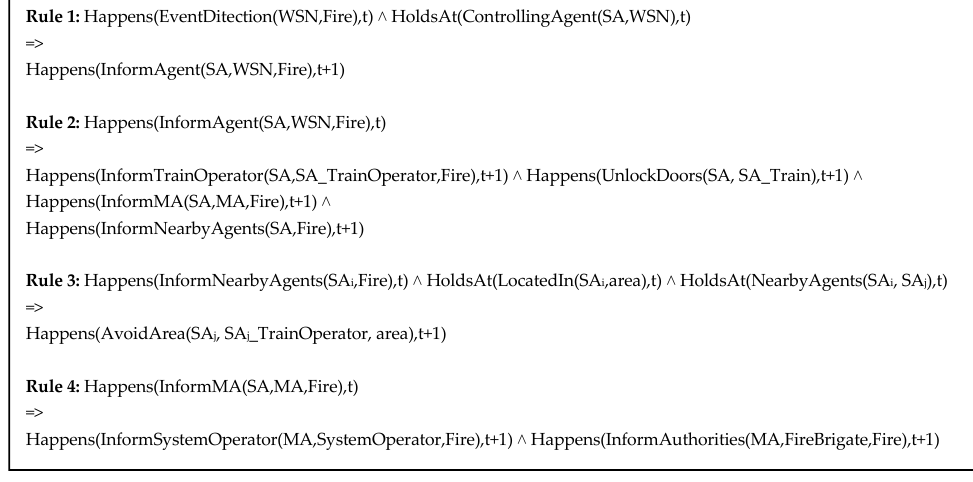
Figure A2. EC rules that perform the main safety reasoning behavior of each intelligent agent.